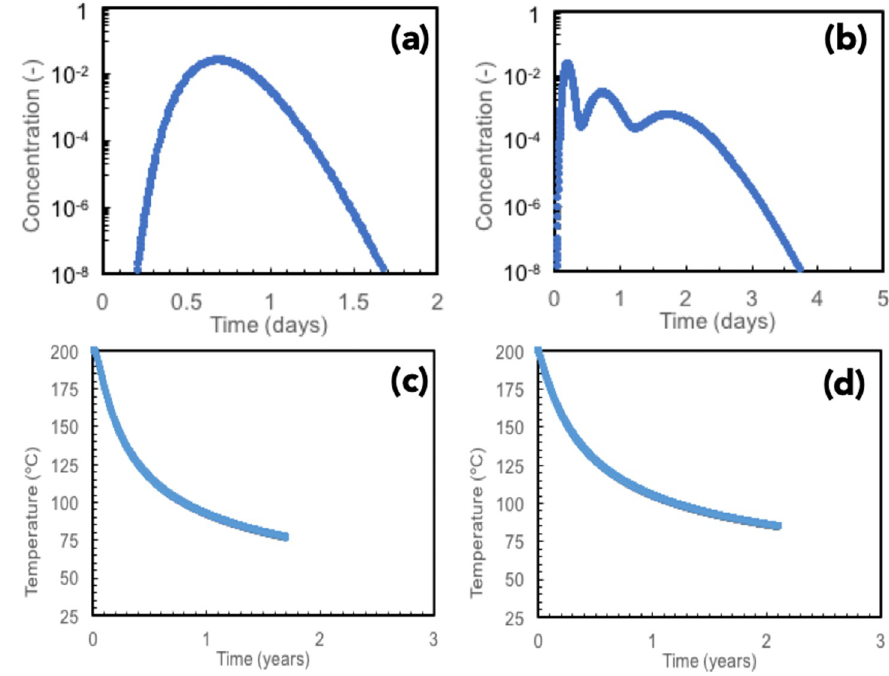
Figure 3. Tracer responses and temperature historires for ( a ) uniform fracture and ( b ) three flow paths, and temperature histories for ( c ) uniform fracture and ( d ) three flow paths.